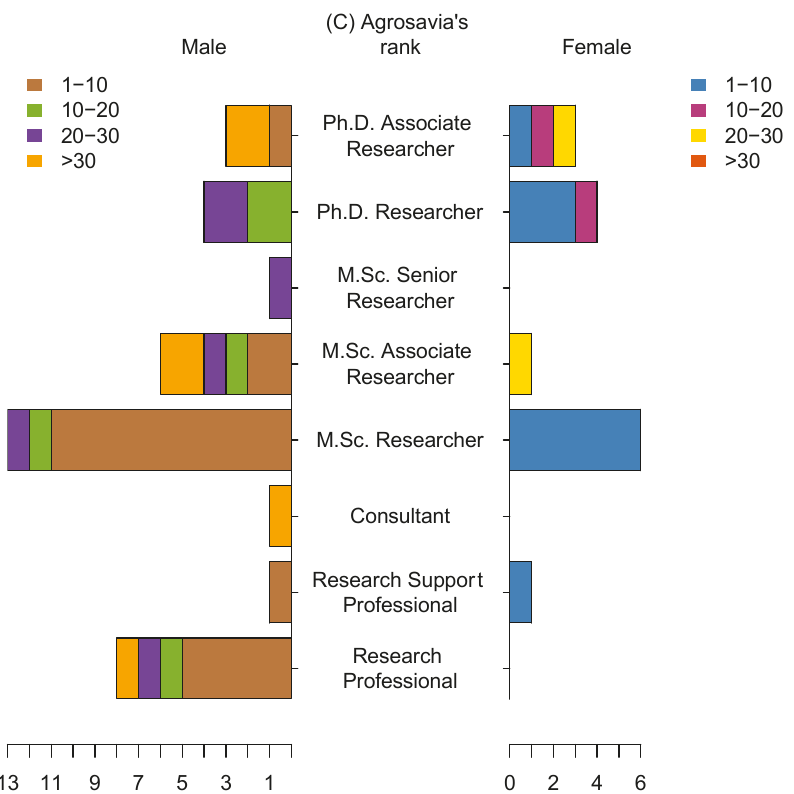
Figure 1. The characterization of 52 researchers working in A GROSAVIA that participated in this study. The number of researchers were categorized by ( A ) age range, ( B ) the highest academic degree obtained in Colombia and abroad, and ( C ) rank category in A GROSAVIA . The horizontal scales represent the number of researchers, with males to the left and females to the right. Table 2. List of crops that researchers in A GROSAVIA work on or have worked with in the last ten years (see Figure 2), and whether or not they are listed as neglected and underutilized species (NUS) at three different levels: Colombia, Andes, and worldwide [4–6]. The crops are in alphabetic order showing the scientific name when applicable (NA—not